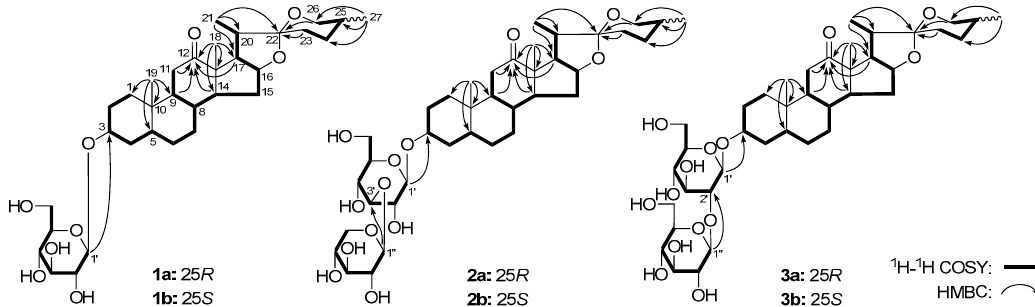
Figure 8. The main 1 H- 1 H COSY and HMBC correlations of 1a – 3a and 1b – 3b .